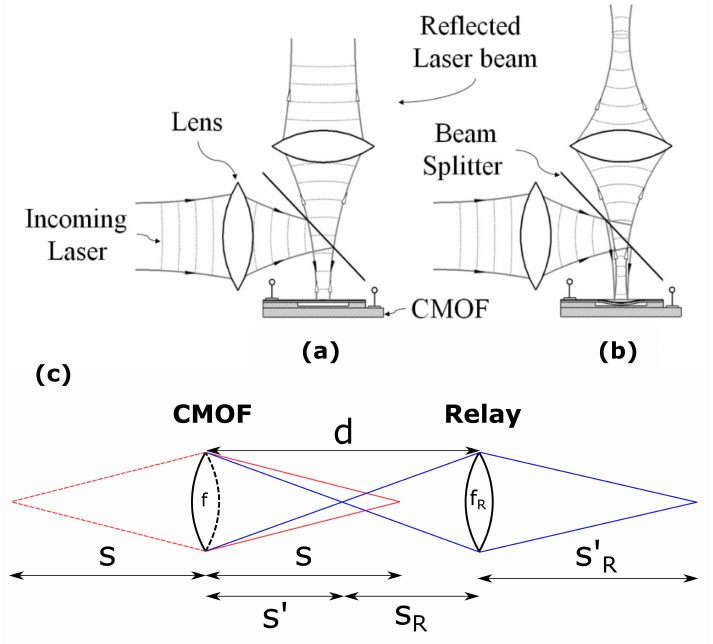
Figure 1. Illustration showing the principle of fast optical focusing with a capacitive micromachined optical focusing (CMOF) deformable MEMS mirror: ( a ) non-deflected CMOF mirror; ( b ) deflected CMOF mirror. ( c ) Illustration of the unfolded geometry of the optical setup. The black dashed line represents the imaginary replacement of a CMOF mirror with a lens. The red solid line represents incident light, and the red dashed line represents the virtual incident light. The blue lines represent refocused